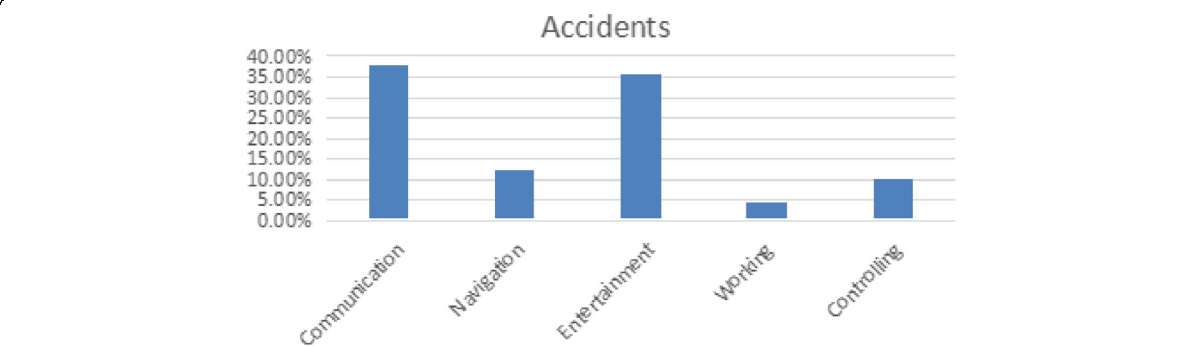
Fig. 11 Proportion of traffic accidents caused by different types of vehicle communication system